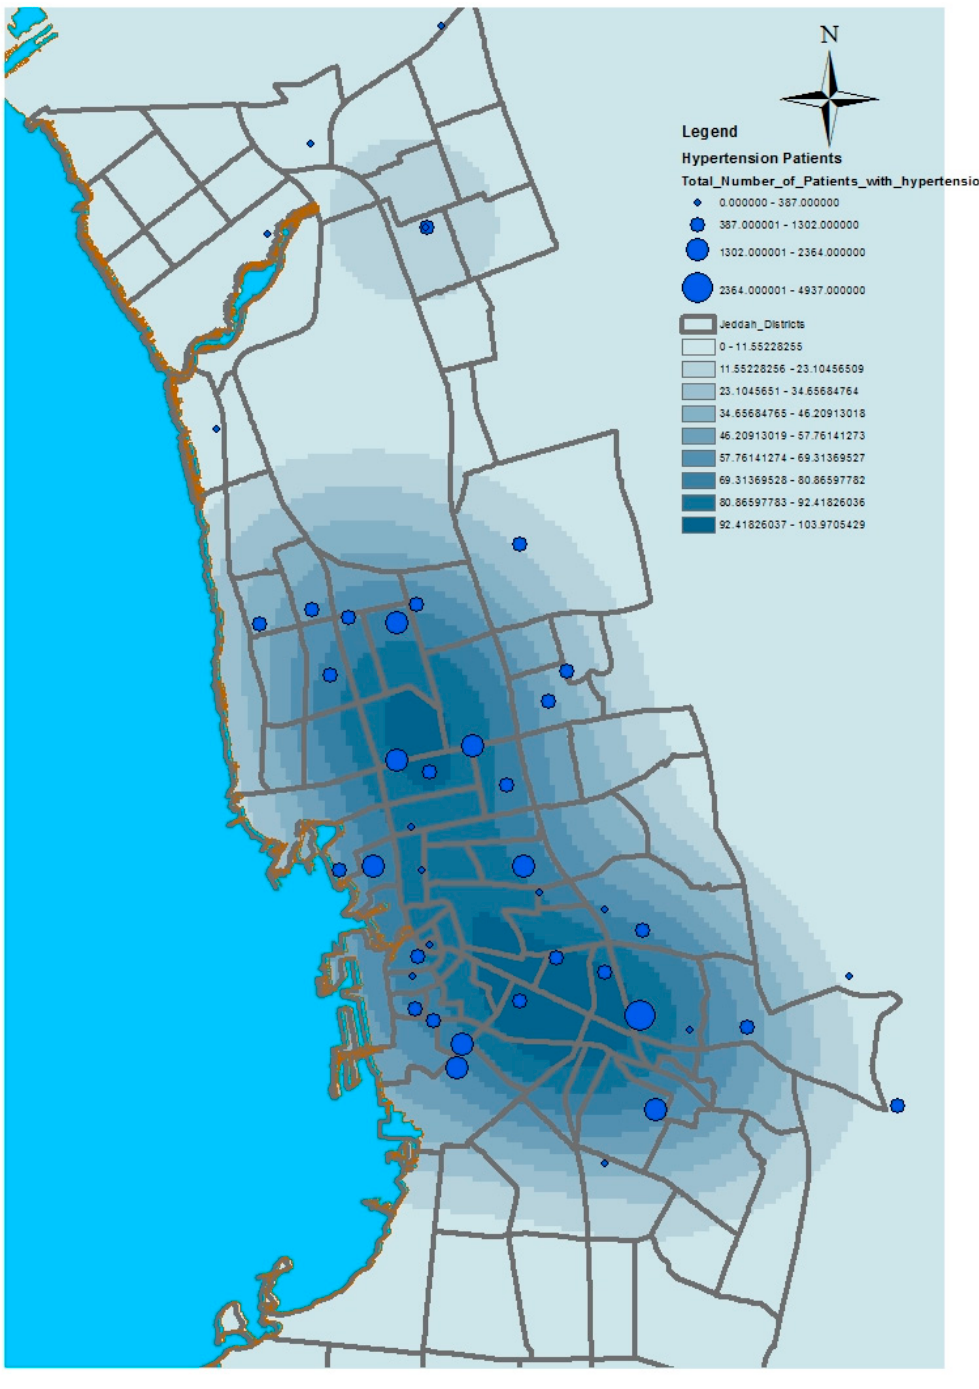
Figure 8. Kernel density for hypertension patients.